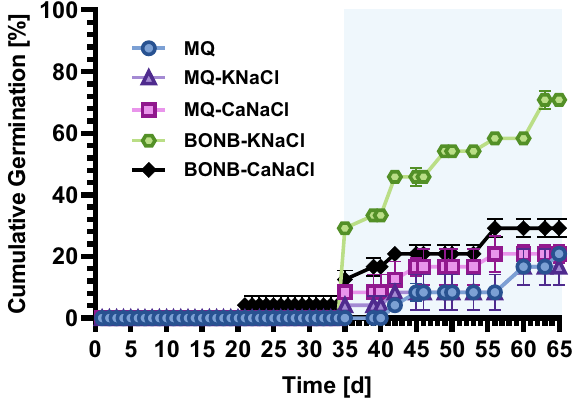
Figure 2. Average cumulative germinations of experiment 2. Figure shows cumulative germination rates of wasabi seeds after conditioning in treatment solution: MQ (milli-Q water), MQ-KNaCl (milli-Q water containing K + , Na + , and Cl − ), MQ-CaNaCl (milli-Q water containing Ca 2+ , Na + , and Cl − ), BONB-KNaCl (bulk oxygen nanobubble solution containing K + , Na + , and Cl − ), and BONB-CaNaCl (bulk oxygen nanobubble solution containing Ca 2+ , Na + , and Cl − ). Error bars indicate standard errors. Data points without error bars indicate no standard